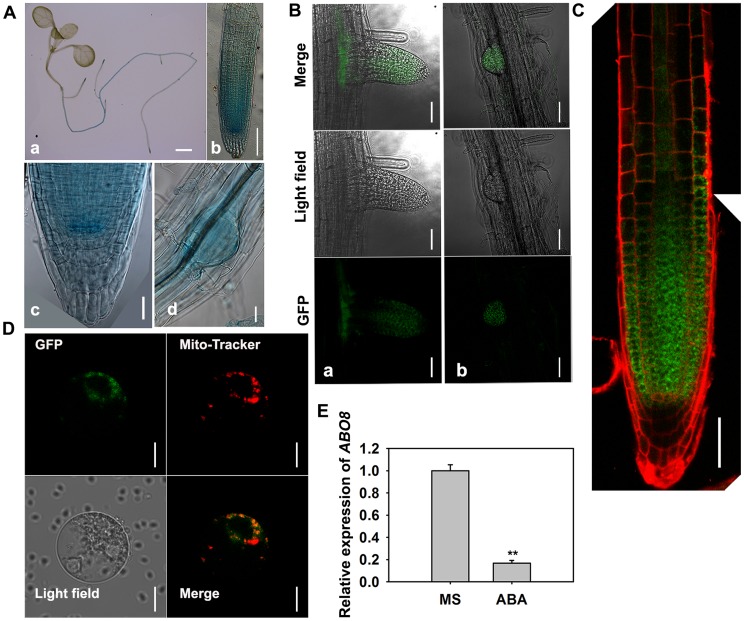
The expression and localization of ABO8.A. The expression pattern of ProABO8:GUS in the whole seedling and roots. a, a seedling, bar = 1 mm; b, a primary root, bar = 50 µm; c, an amplified primary root tip, bar = 20 µm; d, a lateral root primordium, bars = 50 µm. B. The expression of ProABO8:ABO8-GFP in a lateral root (a, left) and a lateral root primordium (b, right). Bars = 50 µm. C. The expression of ProABO8:ABO8-GFP in a primary root. Bars = 50 µm. D. Co-subcellular localization of ABO8-GFP with Mito-Tracker. Bars = 10 µm. E. Expression of ABO8 is reduced by ABA treatment. Seedlings were treated with or without 30 µM ABA for 8 h, and total RNAs were used for qRT-PCR. ACTIN2 was used as a control. Three independent experiments were done with similar results, each with three biological replicates. Results shown are from one experiment. Values are means ±SE, n = 3. **: P<0.01.